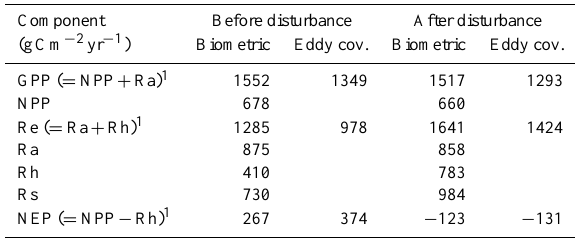
Table 2. Carbon balances at the SAP site before and after the windthrow disturbance. Gross primary production (GPP), ecosys- tem respiration (Re), and net ecosystem production (NEP) were measured by eddy covariance methods. Net primary production (NPP) was calculated by adding together the aboveground net pri- mary production and the changes in Sasa and root biomass. Au- totrophic respiration (Ra) is composed of respirations from leaves, branches, stems, and roots. The Ra values of aboveground parts were estimated by using chambers (Utsugi et al., 2008). The Ra value of root was estimated as the difference between the soil respi- ration (Rs) and the heterotrophic respiration (Rh). The Rh value of coarse-wood debris was estimated in the section 4.2. The Rh values of litter and soil decomposition were estimated by using incubation tests (T. Sakata, personal communication, 2010). The value of Rs was estimated by using chambers (Sakata et al., 2008) The periods before and after the disturbance are 2000–2003 and 2006–2008, re-